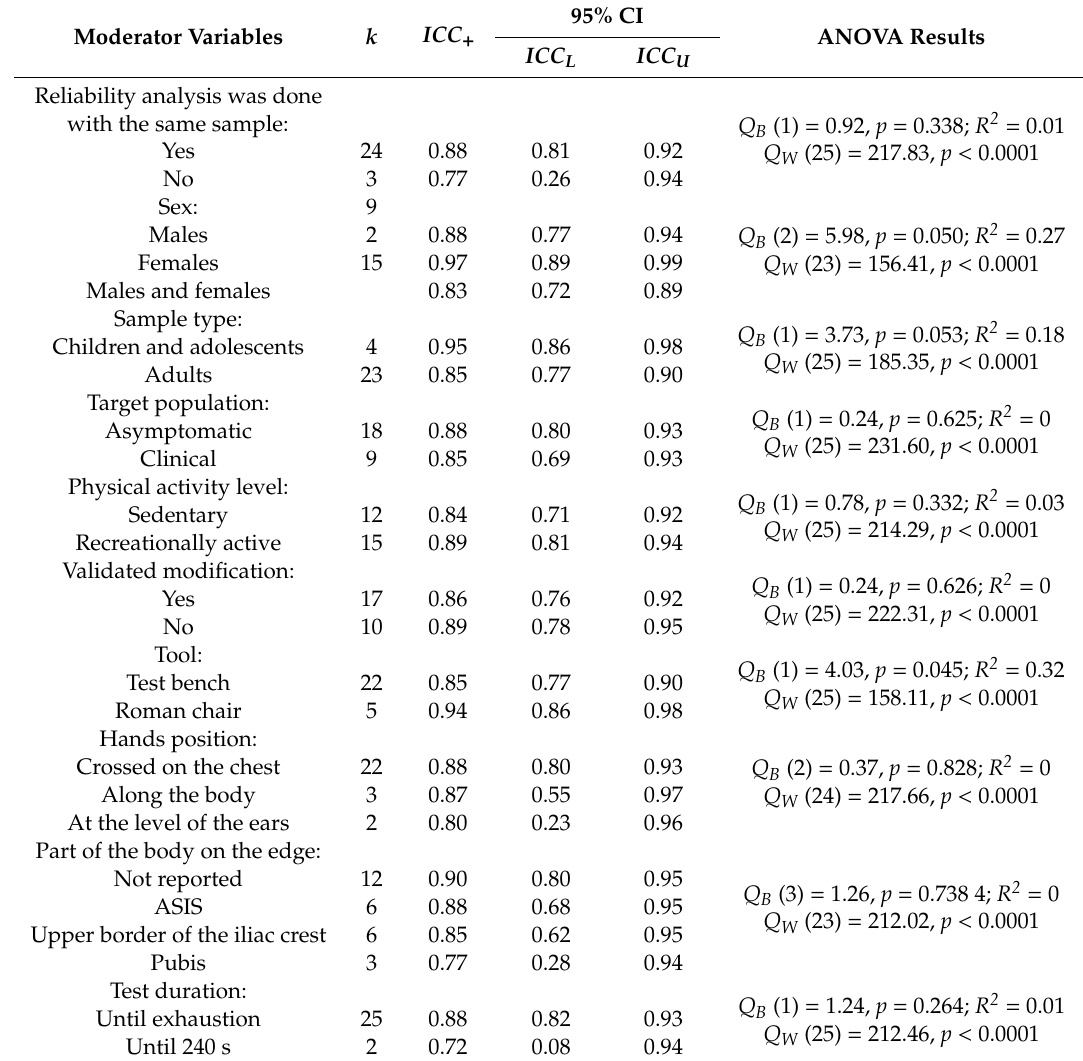
Table 4. Results of the mixed-e ff ects ANOVAs for the qualitative moderator variables on the intraclass correlation coe ffi cient (ICC) estimates obtained from intra-tester and inter-session reliability of the Biering-Sorensen